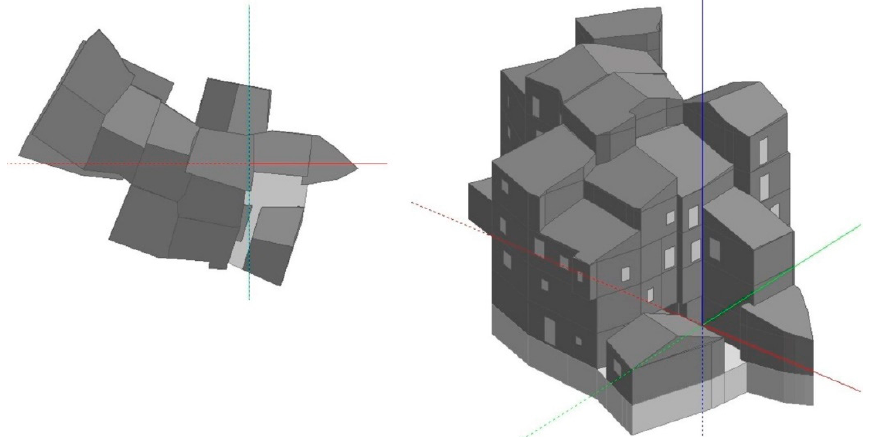
Figure 5. Use of Design Builder software to model the building containing the M1 wall sample.